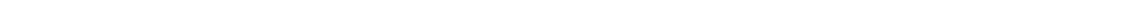
Fig. 1 Loss of myeloid Bmal1 increases pro-in fl ammatory responses. a Sera from naive Bmal1 Myeloid + / + and Bmal1 Myeloid − / − mice were tested by ELISA for IL-12p40 ( n = 7 – 9). b Bone marrow (BM) cells isolated from Bmal1 Myeloid + / + or Bmal1 Myeloid − / − mice was cultured with granulocyte-macrophage colony-stimulating factor (GM-CSF) (20 ng/ml). After 6 days cells were harvested and stimulated with Mycobacterium tuberculosis (MTB) (100 µ g/ml). Supernatants were removed at 24 h and tested by ELISA for cytokine production. c , d Day 6 GM-CSF-expanded BM cells from Bmal1 Myeloid + / + and Bmal1 Myeloid − / − mice were stained for MHCII, PD-L1 or PD-L2 gating on CD11b + CD11c + cells ( n = 6). e BM cells from either Bmal1 Myeloid + / + and Bmal1 Myeloid − / − mice was grown in the presence of GM-CSF. After 6 days cells were harvested and incubated with MTB (100 µ g/ml) or myelin